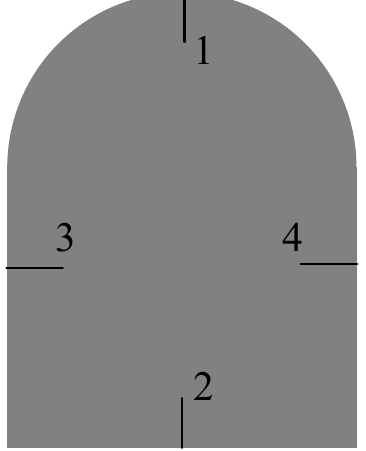
Figure 19. Monitoring points schematic diagram of surrounding rock.